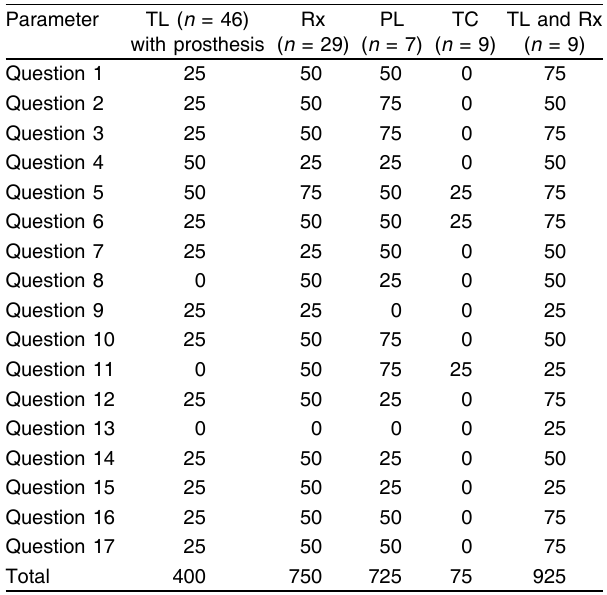
Table 7 The results of the